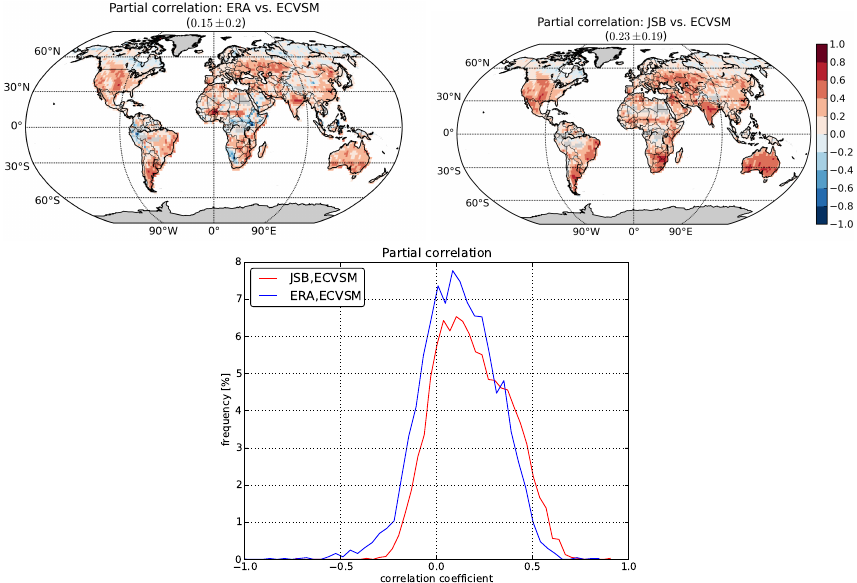
Fig. 7. Correlation coefficients of partial correlation between ERA-interim (left panel) and JSBACH (right panel) soil moisture anomalies against ECVSM soil moisture anomalies with removal of the effect of the respective precipitation forcing.